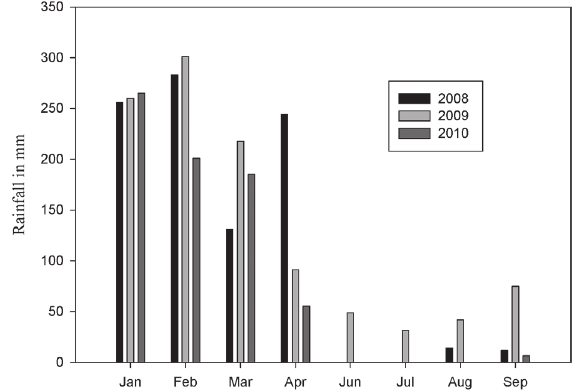
Figure 2 - Total monthly rainfall for wetlands in Mato Grosso, Brazil during the study period.